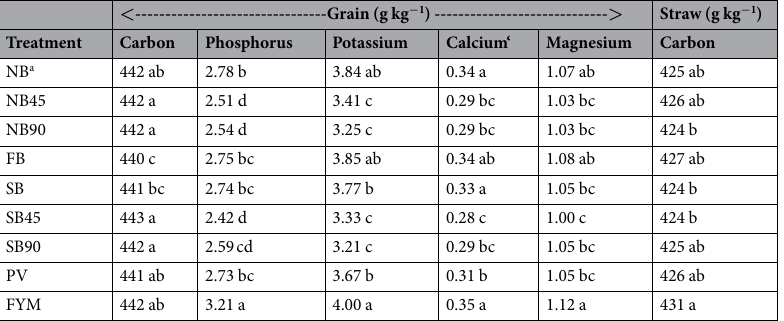
from 1995 to 2015 (Fig. 4B and Supplementary Table S7). Only FYM plots had S above the measurement thresh- old level. Wheat grain has a higher pearling index and decreased dough elasticity when grain S is below the